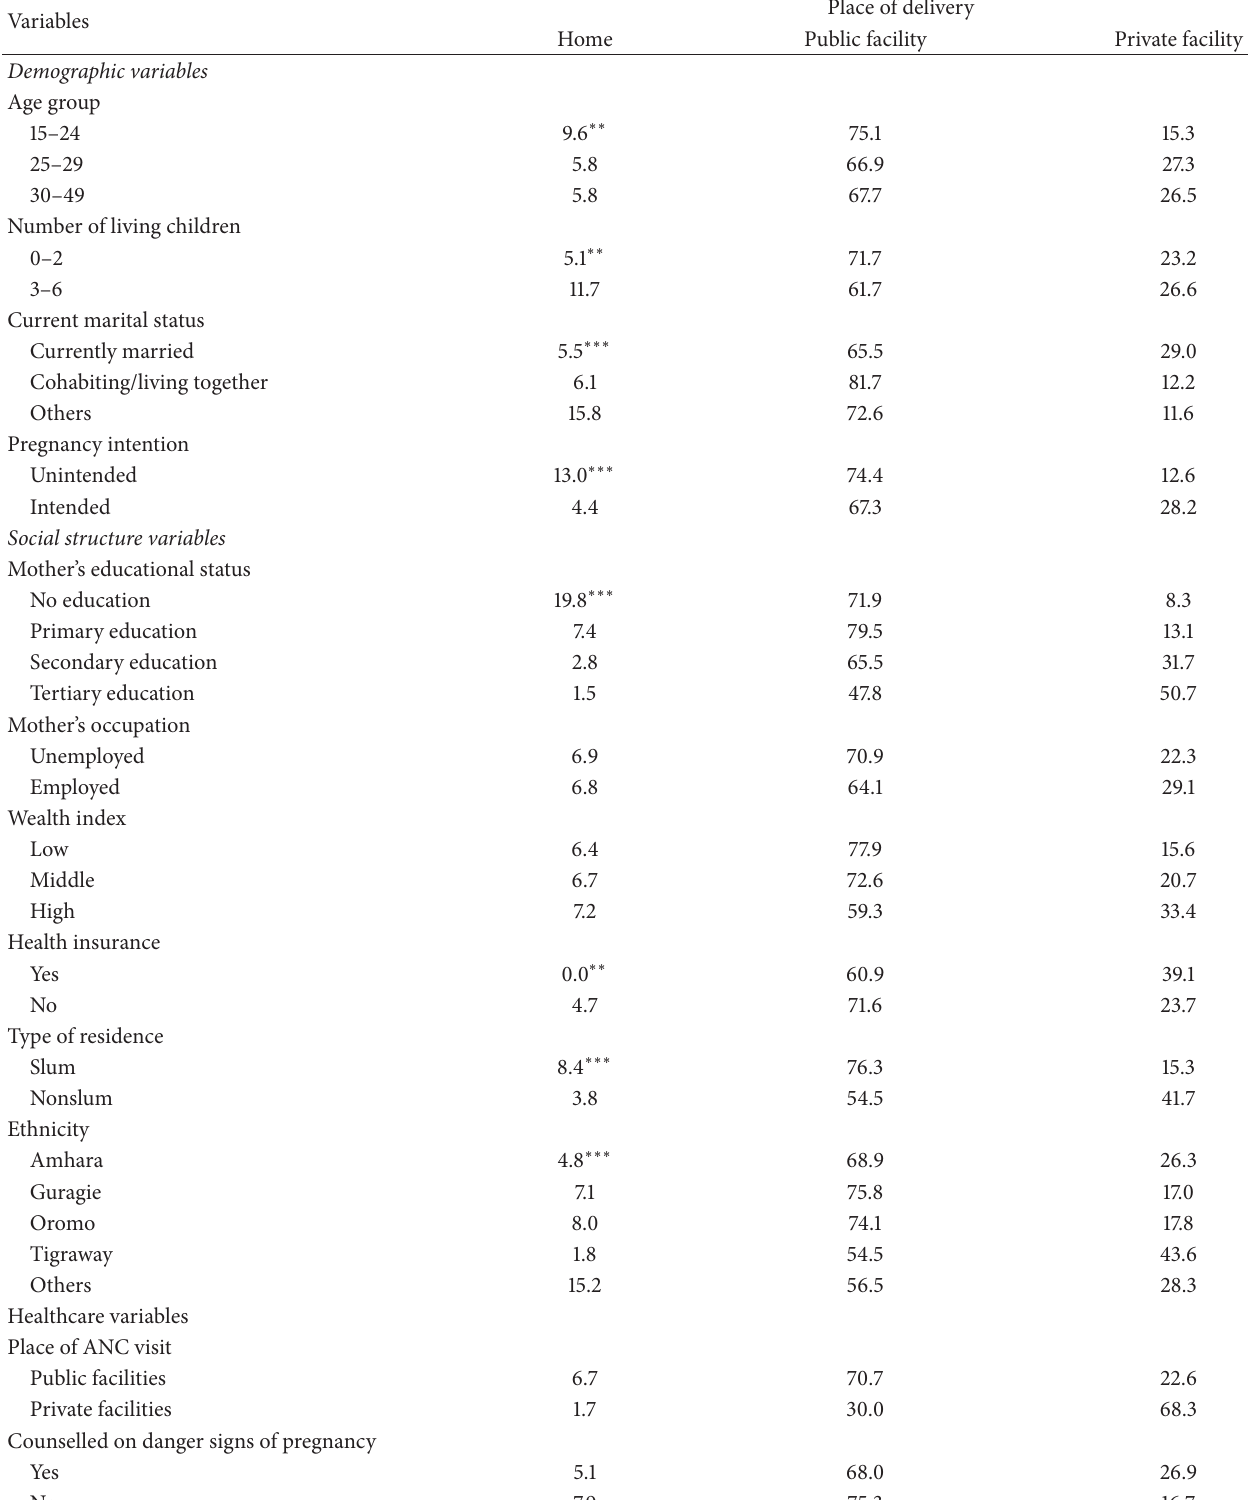
Table 1: Demographic variables and preferred place of delivery, Addis Ababa, January